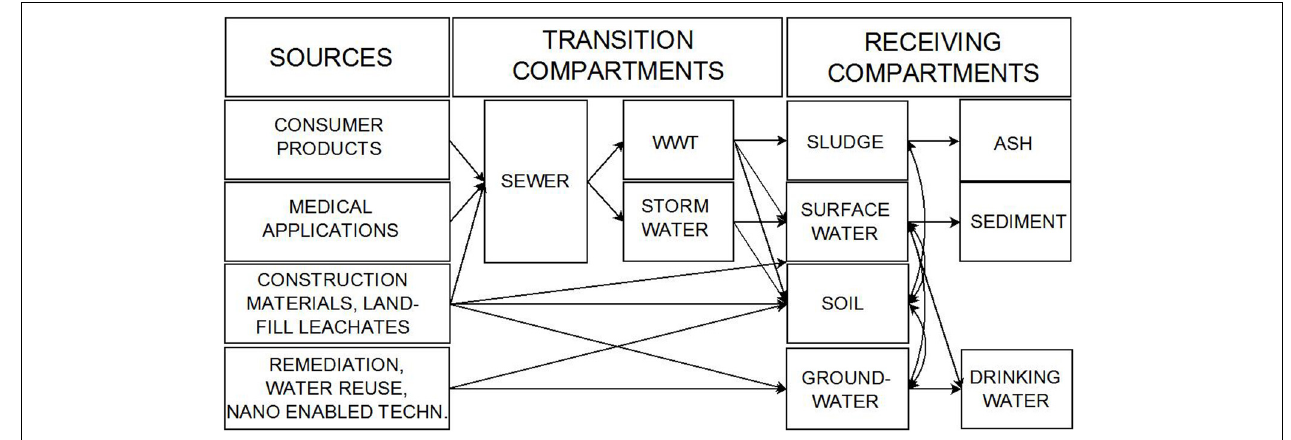
FIGURE 1 | Schematic overview on different potential pathways of ENMs focusing on the urban water